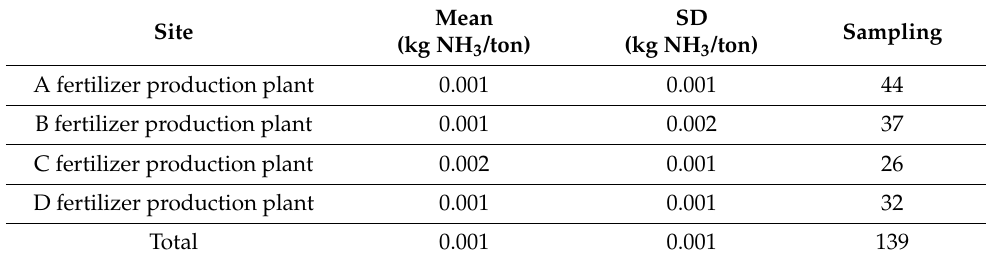
Table 7. NH 3 emission factors of the investigated NPK fertilizer production plants.